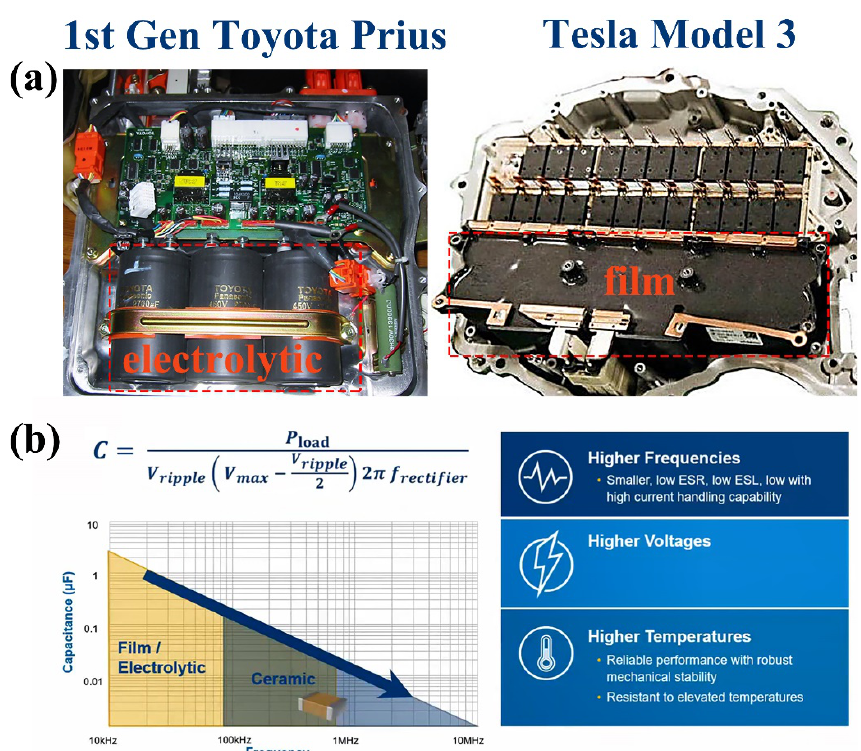
Fig. 37 (a) DC-Link capacitors in the traction inverters of the 1st Gen Toyota Prius and Tesla Model 3 [155,156]. (b) Trends and future requirements for DC-Link capacitors [158].